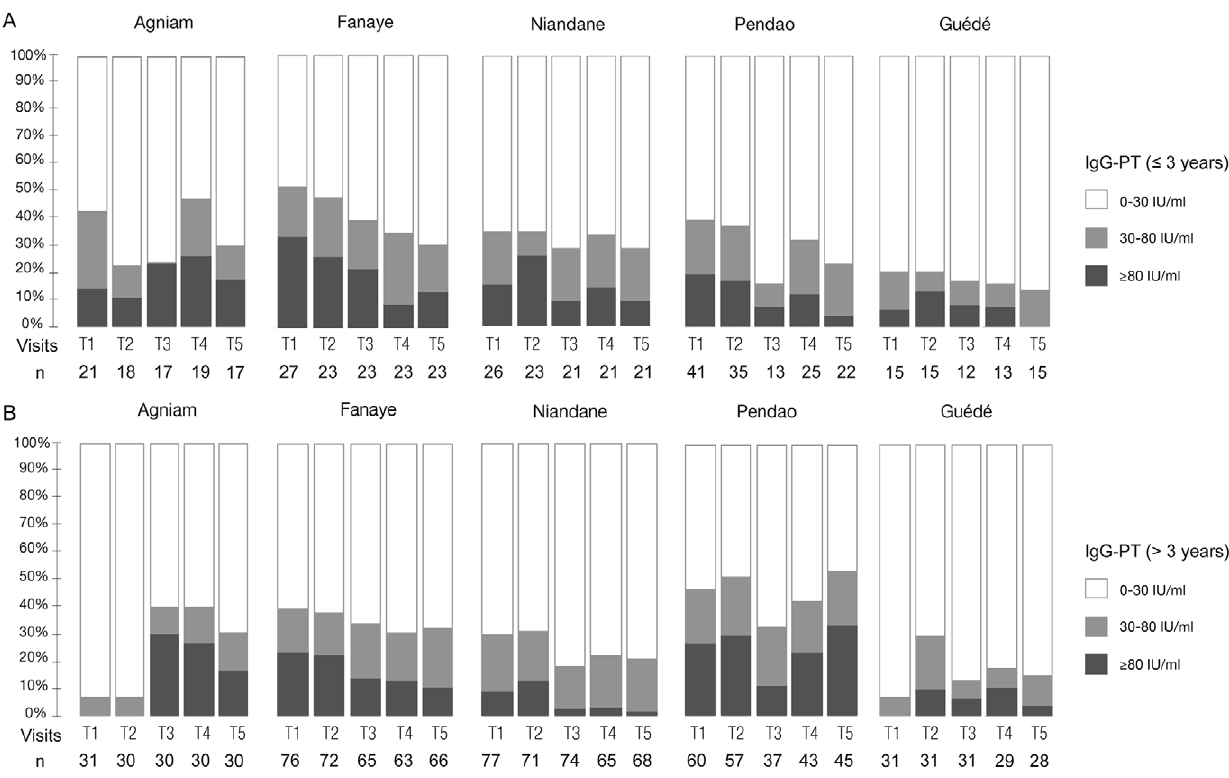
Figure 2. Seroprevalence of anti-PT IgG concentrations according to the village and visit for children younger (panel A) and older than 3 years (panel B). Chi-square test between seropositive children (anti-PT IgG concentration . 30 IU/ml) and seronegative children at each visit within villages: panel A.: Agniam, p=0.3588 ; Fanaye, p=0.5227; Niandane, p=0.4056; Pendao, p=0.4276; Gue´de´, p=0.9928; panel B.: Agniam, p , 0.0008 ; Fanaye, p=0.7641; Niandane, p=0.2280; Pendao, p=0.3292; Gue´de´, p=0.1754.